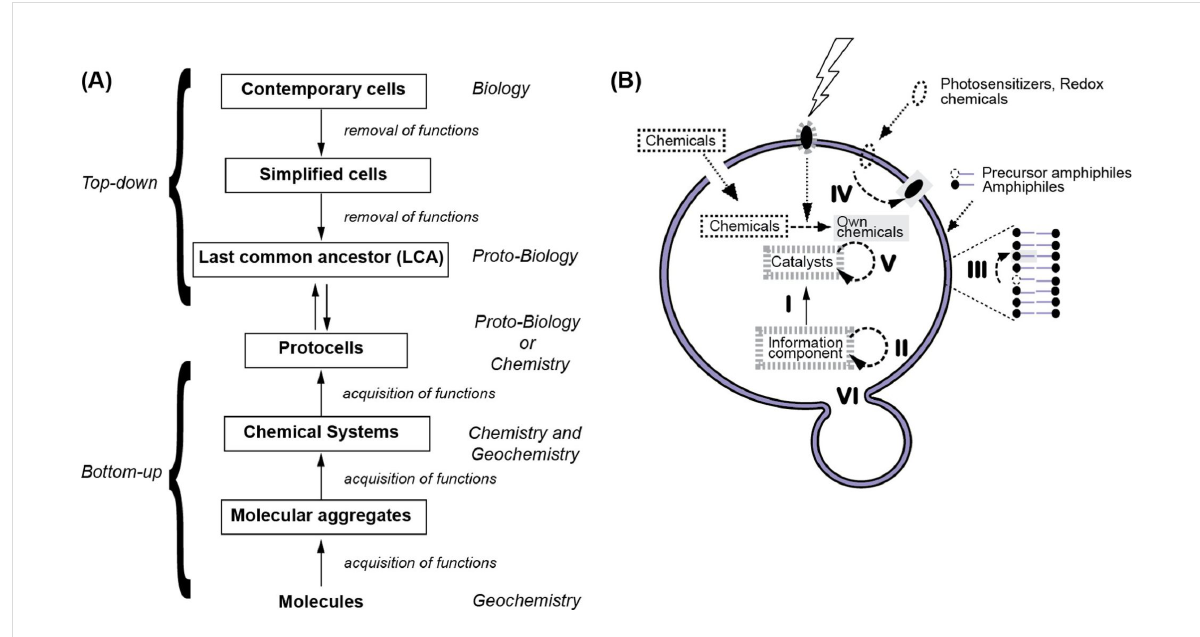
Figure 1: (A) Possible approaches to the historical reconstruction. Two complementary approaches exist: top-down and bottom-up. In the former, the idea is to simplify the cellular architecture and cellular biochemistry by removing redundant or dispensable functions. These are functions that can be either replaced by providing chemicals or taken over by simpler chemicals easily synthesized by, e.g., “non-coded” protein catalysts, or performed, perhaps less efficiently, by other catalysts in the cells. The process should be repeated until a very simple putative “protocell” stage (vide infra) is attained. This is likely a point in time at which biology did not yet exist, but instead pure chemistry defined the protocellular reaction network. The latter approach is based on the use of molecule sets that can self-assemble into chemical aggregates and systems that will then be able to perform an increasingly more complex chemistry. These systems are precursors of protocells that preceded the emergence of ancestral cells. (B) Putative repre- sentation of a protocell (adapted from [3]). Independently of the type of chemicals involved, e.g., pure RNA catalysts/”genetic” information or peptide/ RNA, a protocell should contain three components: a compartment, a catalytic and energy harvesting machinery, and an information system. These components should work in an interconnected fashion to achieve the prolonged activity necessary for the protocell evolution. The interconnectedness in the systems is visible if one considers the various arrows between molecules/components: The catalytic machinery is defined and controlled by the information component (I) and the compartment (via encapsulation), whose molecular species are in turn produced by the catalytic machinery (II: information replication, III: amphiphile production, IV: energy harvesting and chemical replication, and V: catalyst amplification, which can lead to VI: replication process of the whole protocell). The compartment will also define the access of the protocell to environmental resources and, in part, the energy harvesting capabilities. It will also be instrumental in the replication (VI). It might also permit an interface-driven multiphase chemistry (see text below). Molecular precursors (i.e., resources to build protocell chemicals) are highlighted by black dotted structures or frames. Original chemicals of the protocell are highlighted by thick grey dotted frames. Products of the catalytic machinery are placed over a grey background. The involvement of catalysts is depicted by dashed arrows, that of information components with a plain arrow, and that of the compartment (expect the encapsulation) by dotted arrows. Note that the energy-related aspect would be involved in all chemical syntheses but, for the sake of clarity, is only shown